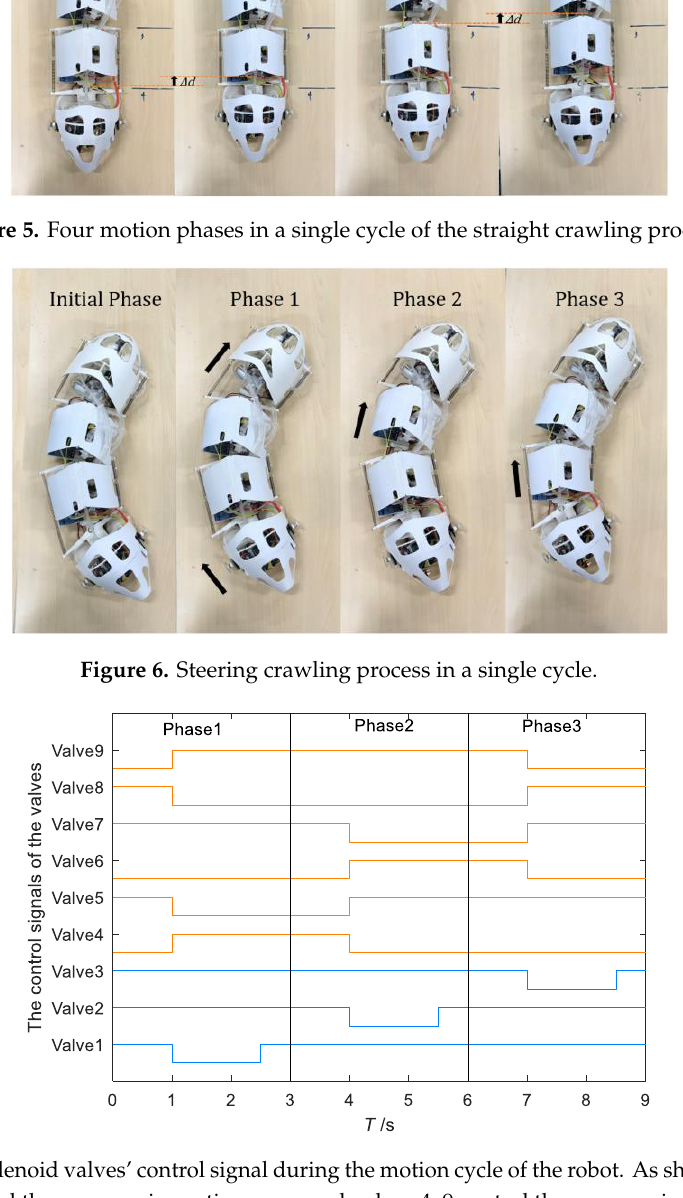
( c ) Figure 8. A simplified geometric model of the robot in Phase 1, where MN is the cylinder of Segment 1, NO is the cylinder of the Segment 2, and OP is the cylinder of Segment 3: ( a ) The state at the beginning of Phase 1; ( b ) The state at the end of Phase 1; ( c ) The simplified model after the introduction of the springs. Taking the steering movement to the right as an example, as shown in figures 8 a,b, we define 𝜃 1 , 𝜃 2 and 𝜃 3 as the deflection angles of Segment 1, Segment 2, and Segment 3 of the robot, respectively. In Phase 1, segments 1 and 4 move forward, while segments 2 and 3 are consolidated with the ground, so the deflection angle 𝜃 2 is constant. At the end of Phase 1, 𝜃 1 and 𝜃 3 are mainly affected A